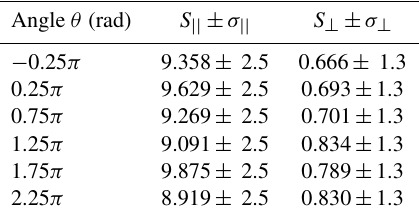
Table 2. Parallel and perpendicular signals for angles diagnostic of symmetry in the measurements. Each signal is effectively the same at 0.25 π and 0.75 π radians and integer multiples